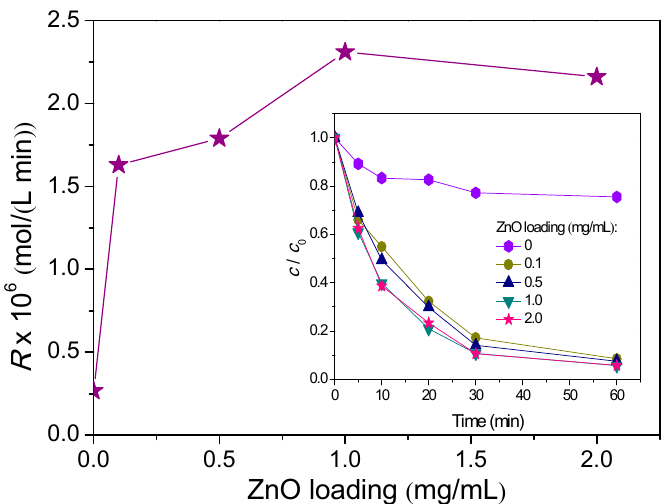
Figure 4. Effects of ZnO loadings on the photocatalytic degradation rate of AMI, calculated for the first 20 min of solar irradiation. Inset represents effects of ZnO loadings on the kinetics of photocatalytic degradation of AMI.